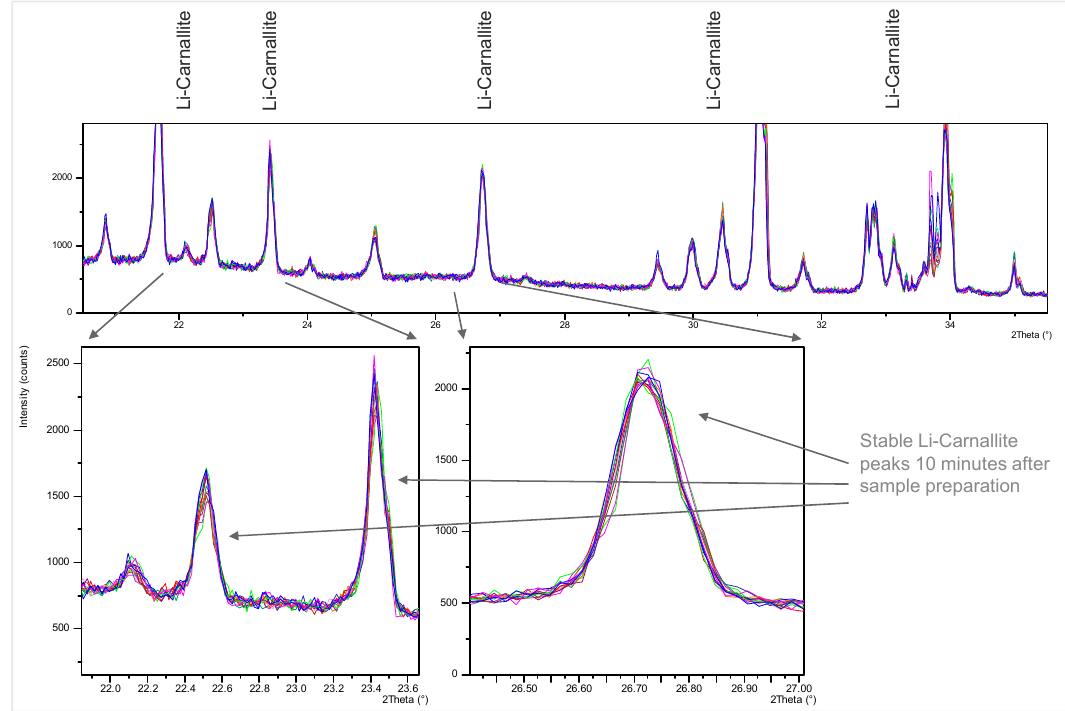
Figure 42. XRD measurement of one brine sample containing lithium carnallite using capton foil on top of the sample, measured in 1 min intervals directly after preparation.